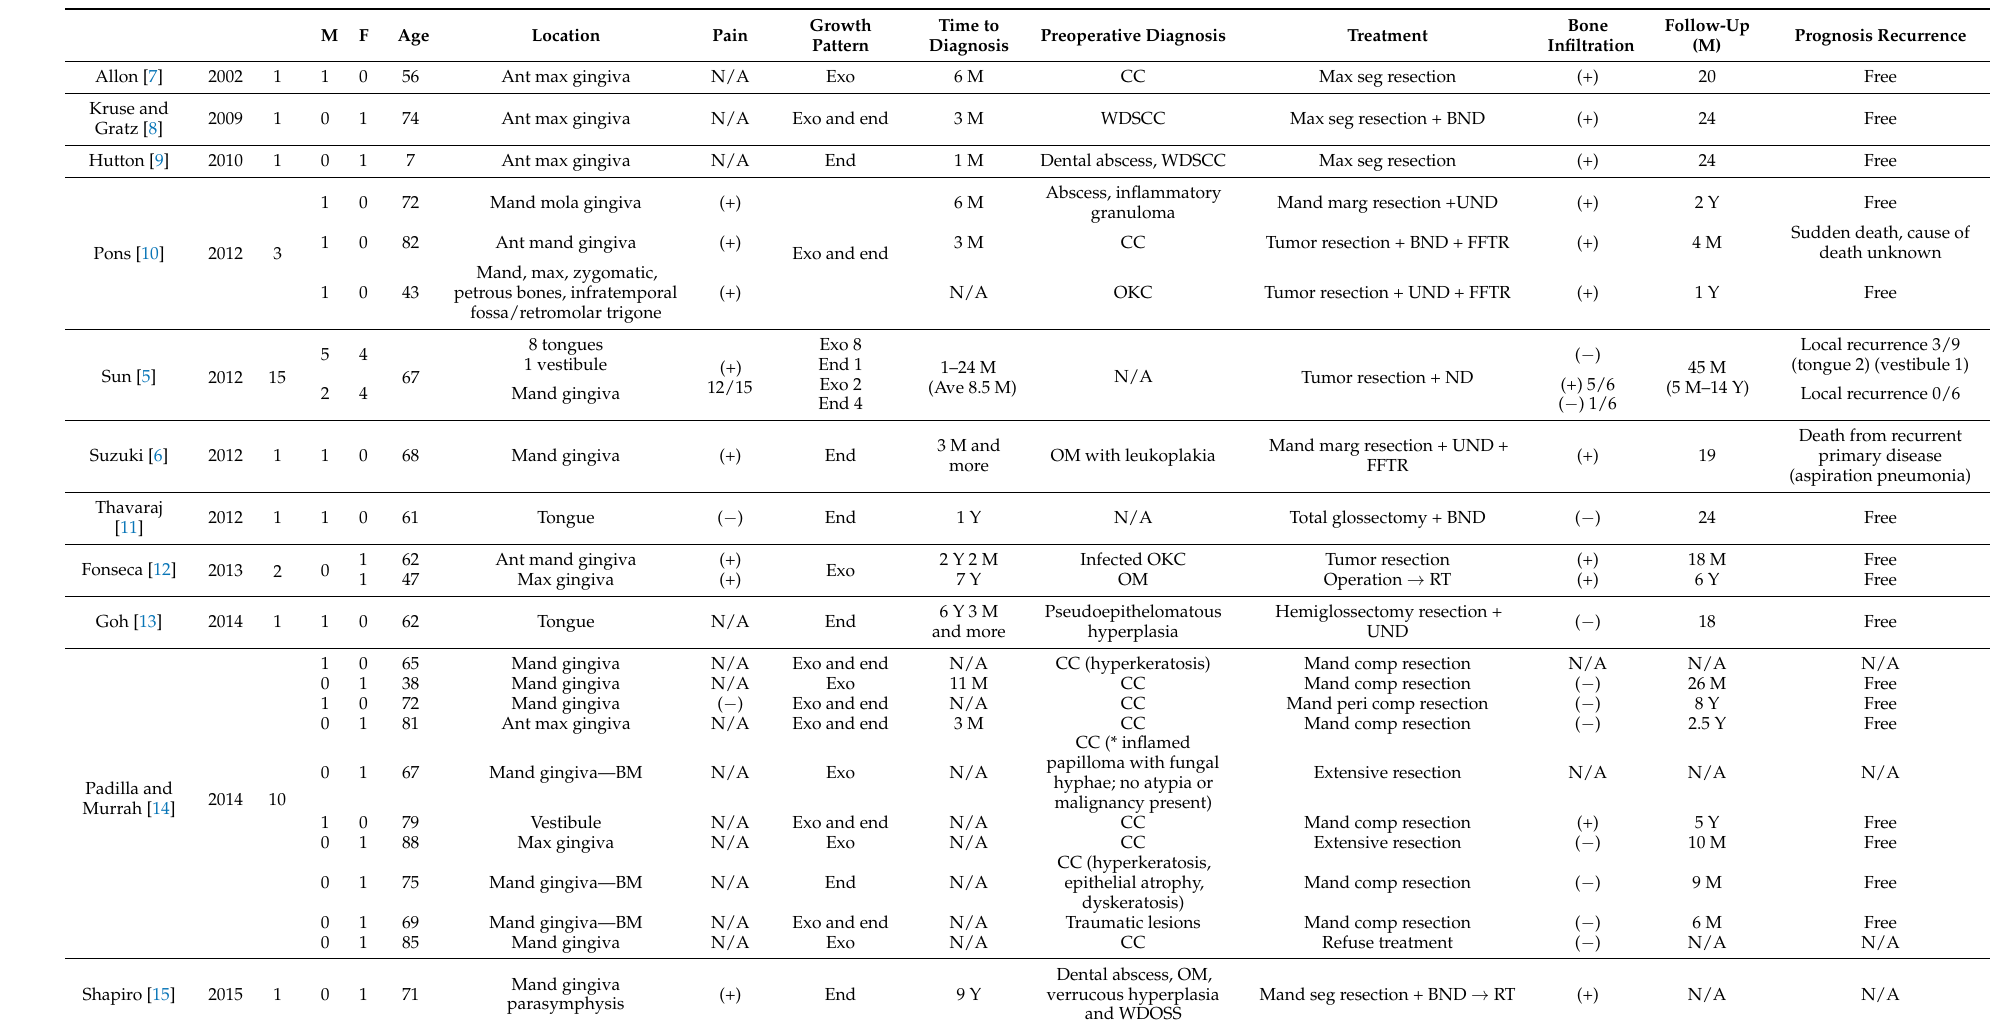
Table 2. List of oral carcinoma